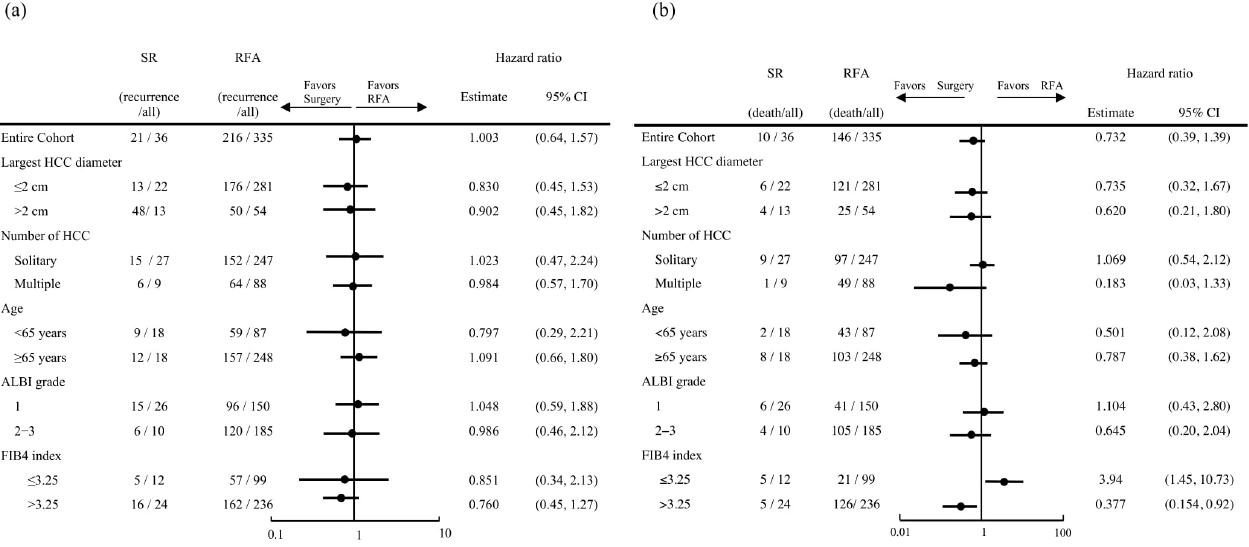
Figure 2. Subgroup analysis of recurrence-free survival (RFS) and overall survival (OS) in surgical resection (SR) and radiofrequency ablation (RFA) groups. ( a ) RFS did not differ significantly be- tween the SR and RFA groups after dividing into subgroups. ( b ) OS was significantly better RFA with FIB4 index ≤ 3.25, while SR with FIB4 index > 3.25 ( p < 0.01). index ≤ 3.25, while SR with FIB4 index > 3.25 ( p <